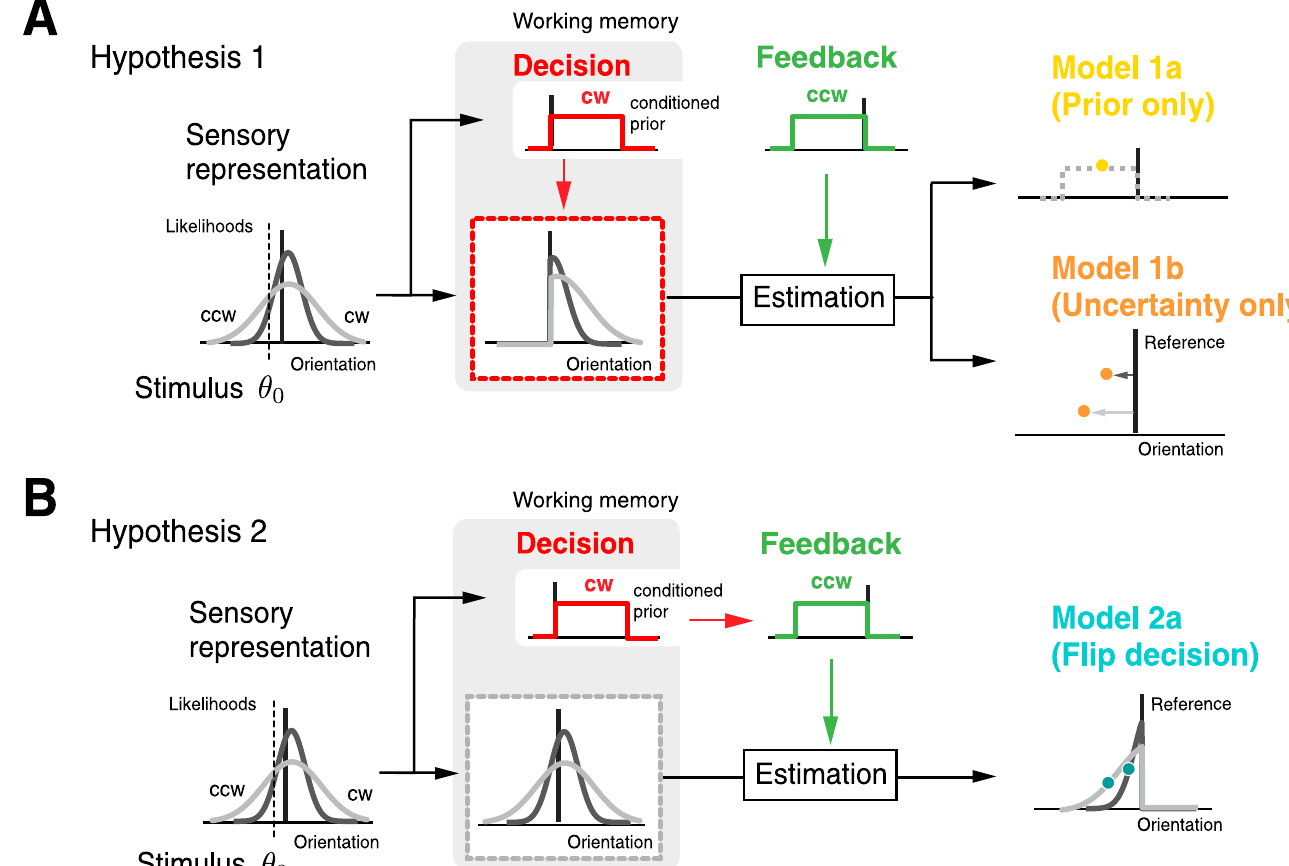
Fig 2. Modeling stimulus estimation after receiving negative feedback. (A) Hypothesis 1: After making a categorical judgment, working memory is updated to only reflect the stimulus information consistent with the decision (i.e., the posterior). We considered two models of how an observer forms an estimate under this condition upon receiving feedback that the decision was incorrect. Model 1a (prior only) assumes that the observer has access to the stimulus prior associated with the correct category. In contrast, Model 1b (uncertainty only) assumes that the observer only has knowledge of the overall sensory uncertainty. As a crude approximation of behavior in correct trials for which larger stimulus noise generally results in larger repulsive biases, we made the heuristic assumption that the observer picks an estimate away from the reference orientation that corresponds to this uncertainty value. (B) Hypothesis 2: Sensory representation (i.e. the entire likelihood function) is preserved in memory and only the conditioned prior is updated when feedback indicates an incorrect choice. Model 2a (flip decision) posits that the observer can freely recombine the recalled sensory representation with the updated prior to perform a Bayesian